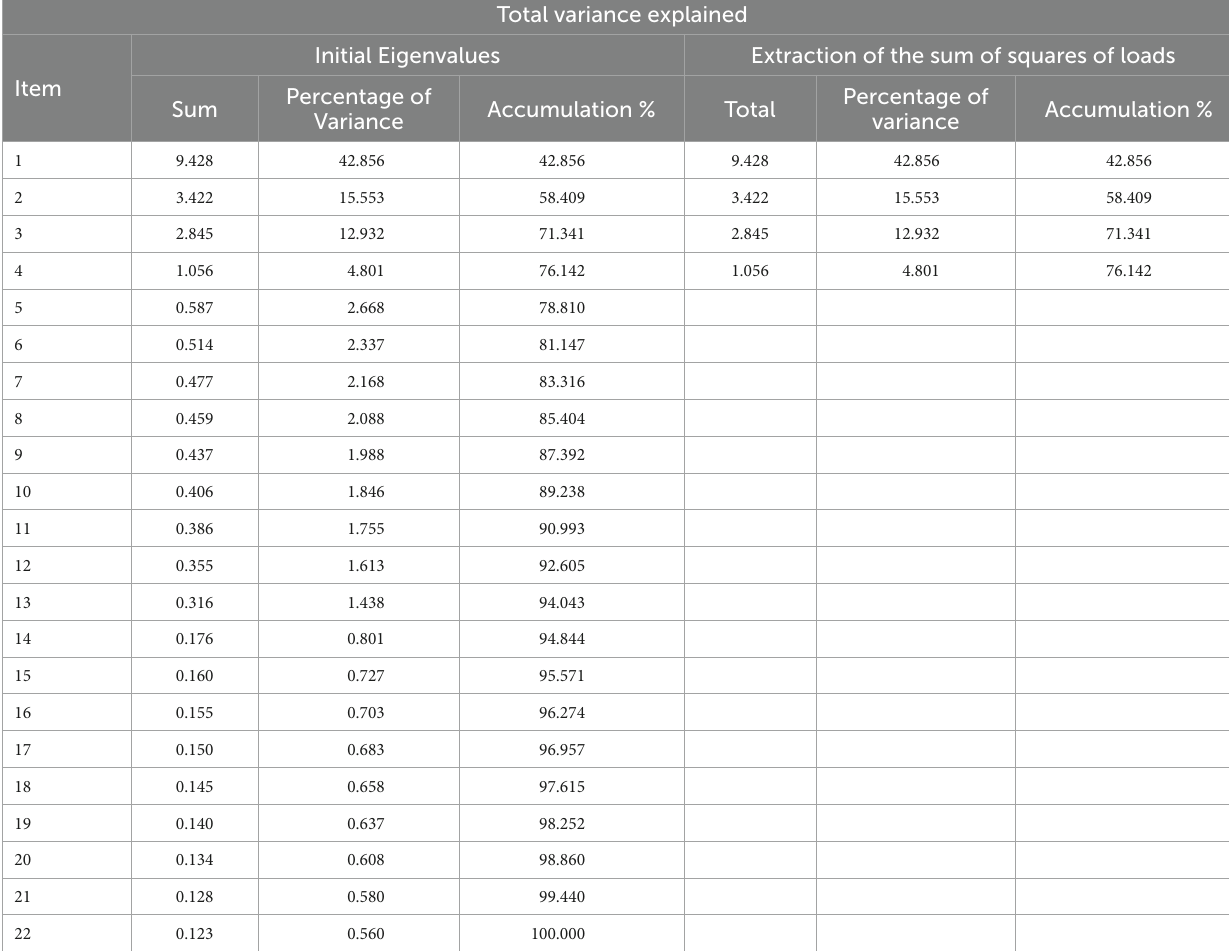
TABLE 5 Factor analysis to verify common method